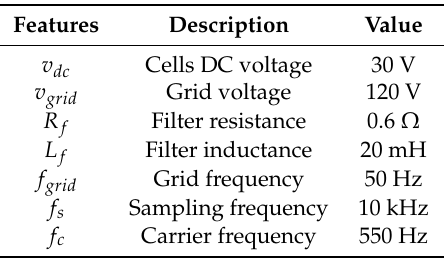
Table 2. System’s